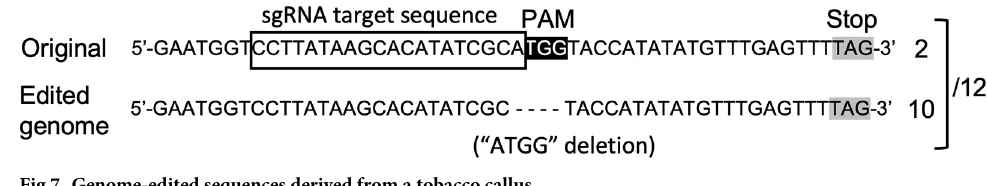
Fig 7. Genome-edited sequences derived from a tobacco